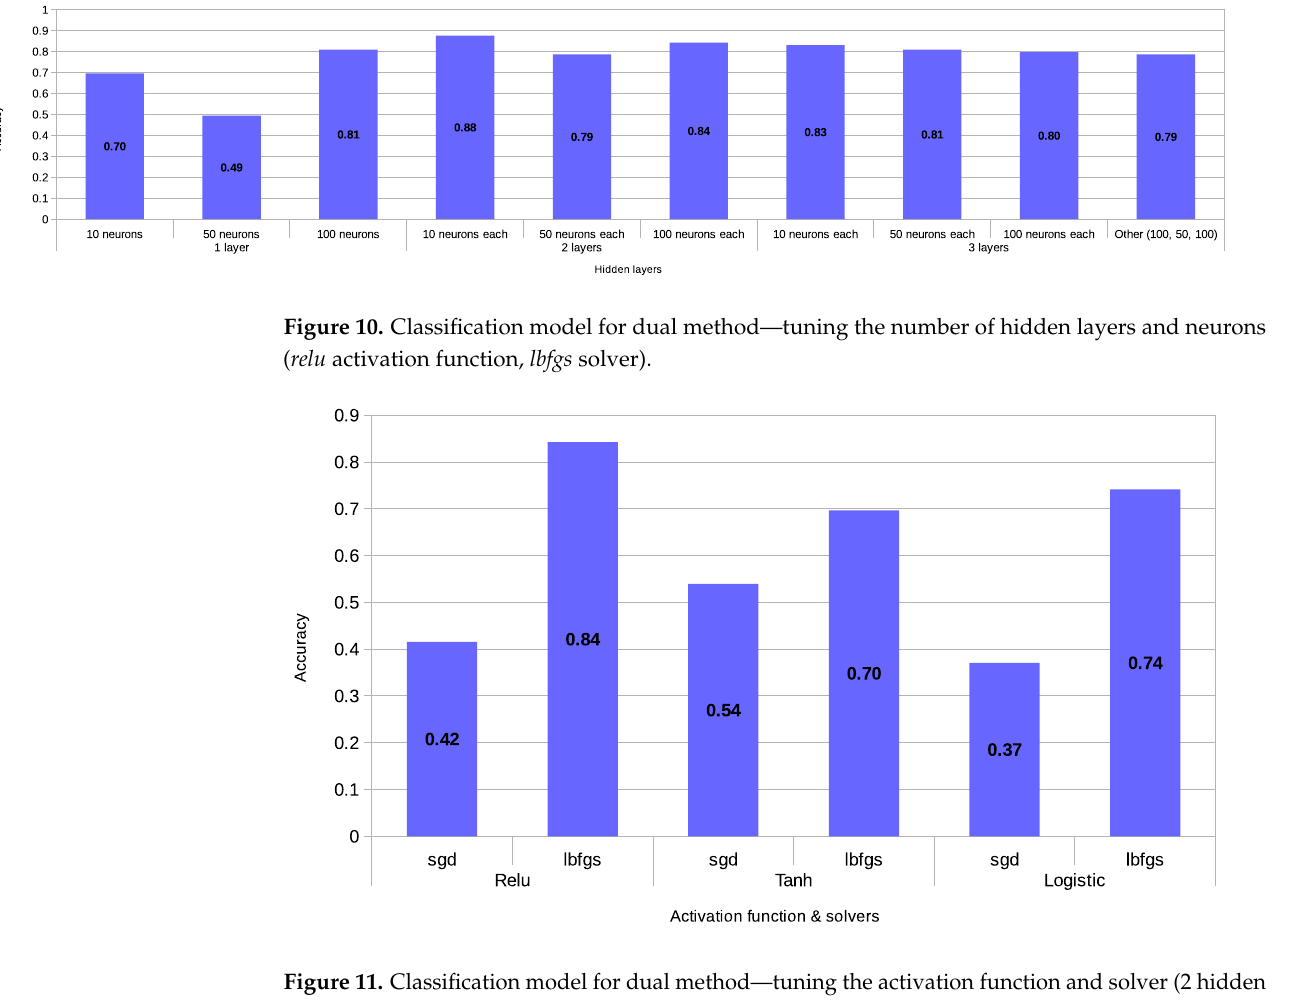
Figure 11. Classification model for dual method—tuning the activation function and solver (2 hidden layers, 100 neurons each).